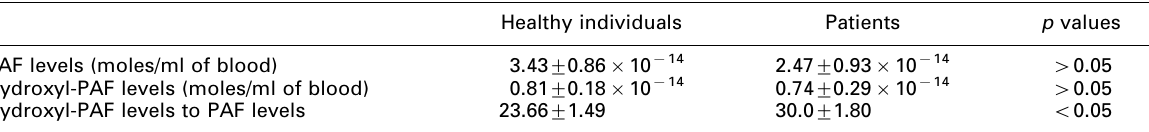
Table 1. PAF and hydroxyl-PAF analogue levels in blood collected from five periodontally healthy volunteers as well as from five patients with chronic adult